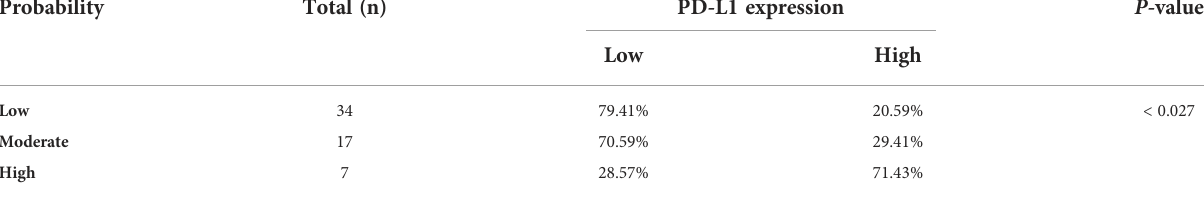
TABLE 3 Multivariate analyses of predictors of PD-L1 levels in patients with renal cancer patients. TABLE 4 PD-L1 expression in the low-, moderate-, and high- potential group. Probability